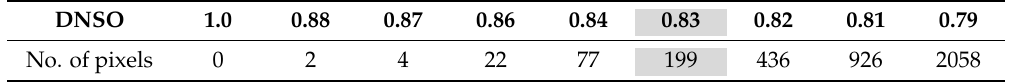
Table 2. Day-Night Spectral Opposite (DNSO) values output.